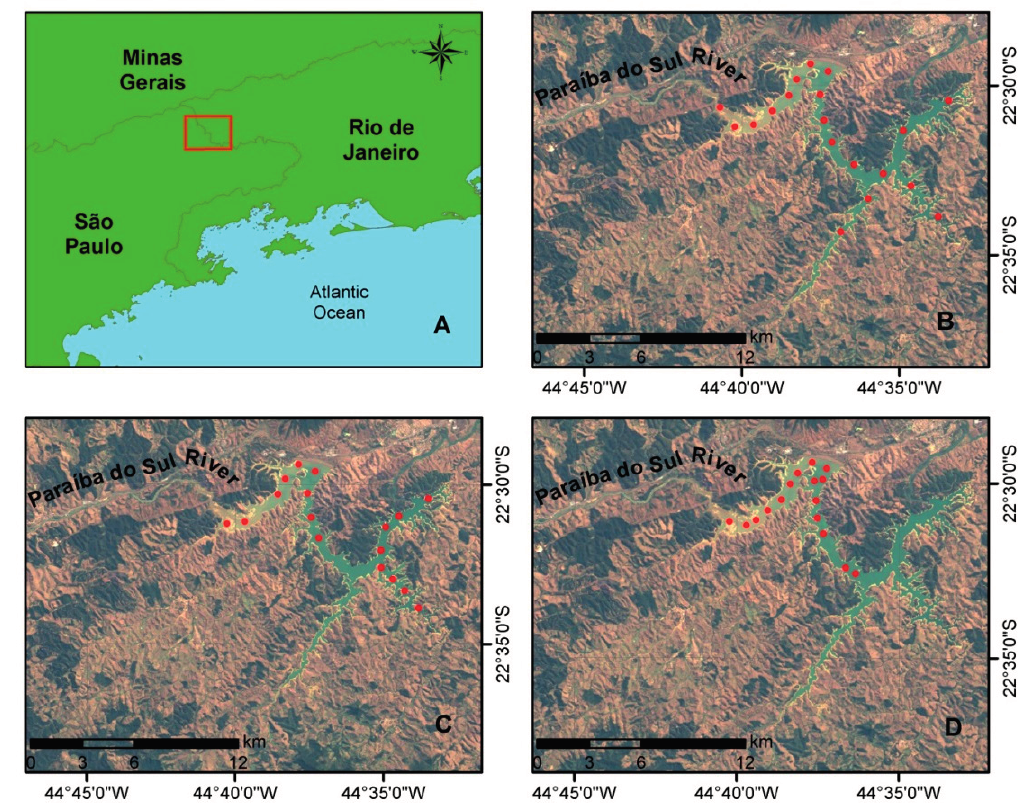
Figure 1. ( A ) Location of Funil Hydroelectric Reservoir. Sampling points from: ( B ) May 2012, ( C ) September 2012; and ( D ) April 2013. Color Composite TM-Landsat5 R3G2B1. Orbit/Point: 218/76. Date of Passage: 5 September